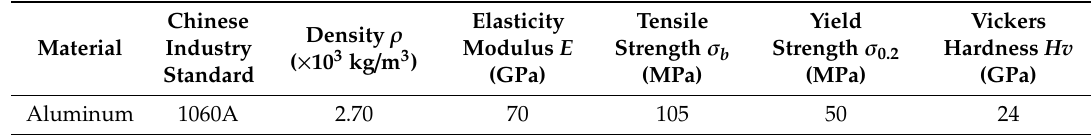
Table 3. Physical properties of specimen.